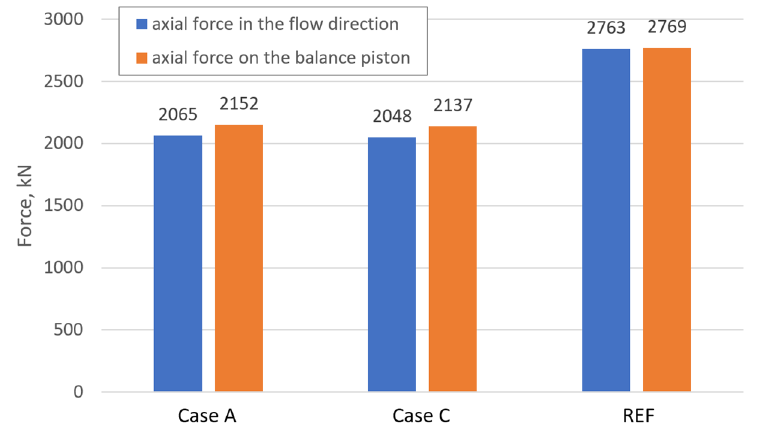
Figure A1. Axial forces acting on the rotor of IP section.